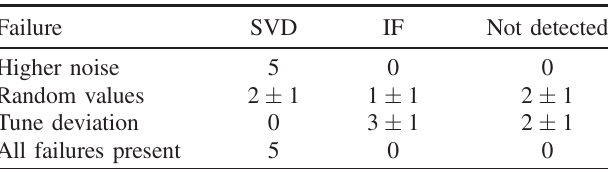
TABLE IV. Cleaning results applying the SVD cut optimal value 0.3 and adjusting the IF contamination factor to 0.01. The results differ from the cleaning using the default setting for all introduced failure modes.